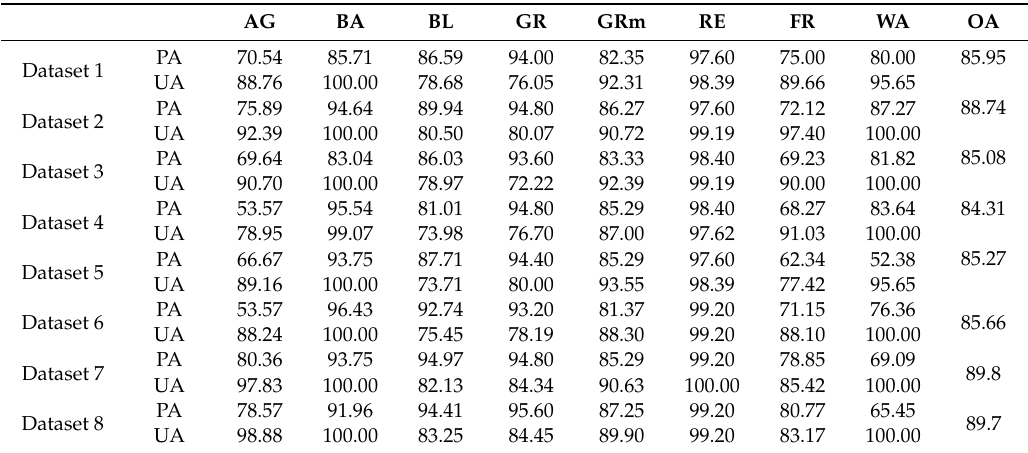
Table 3. User’s (UA), producer’s (PA) and overall (OA) accuracies of land cover classes from the classification results of the eighti ff erent datasets.